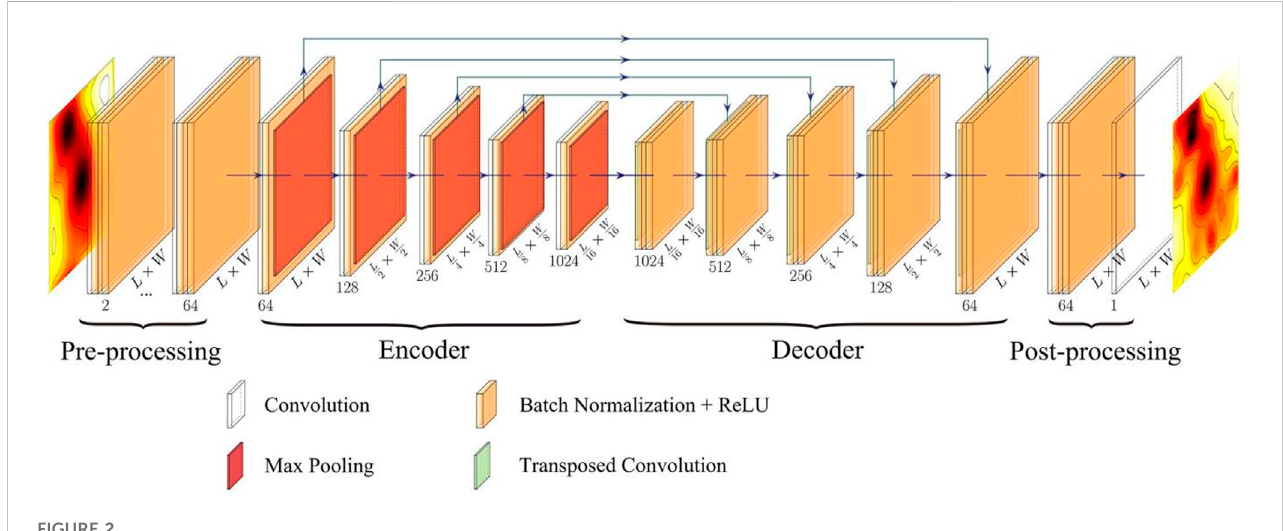
FIGURE 2 Structure of DC-Net.